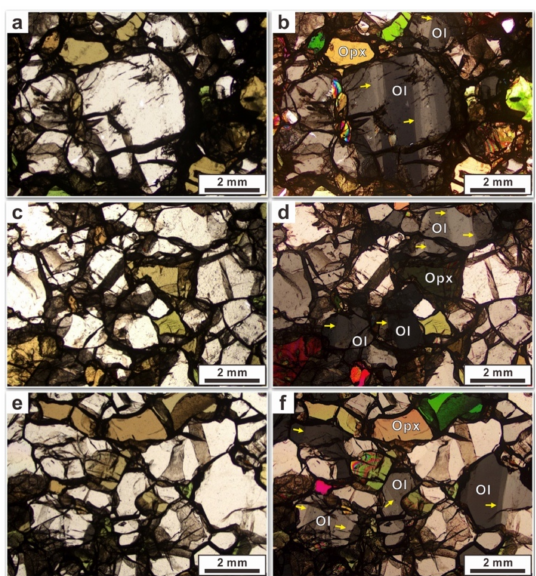
Figure 3. Optical photomicrographs of small-scale thin sections in plane-polarized light ( a , c , e ) and cross-polarized light ( b , d , f ) illustrating the typical microstructures from the Baekdusan peridotite xenoliths. ( a , b ) Coarse-granular peridotite (BD-19). ( c , d ) Fine-granular peridotite (BD-17). ( e , f ) Fine-granular peridotite (BD-21). Ol (olivine), Opx (orthopyroxene). Yellow arrows denote subgrain boundaries and / or undulose extinction in